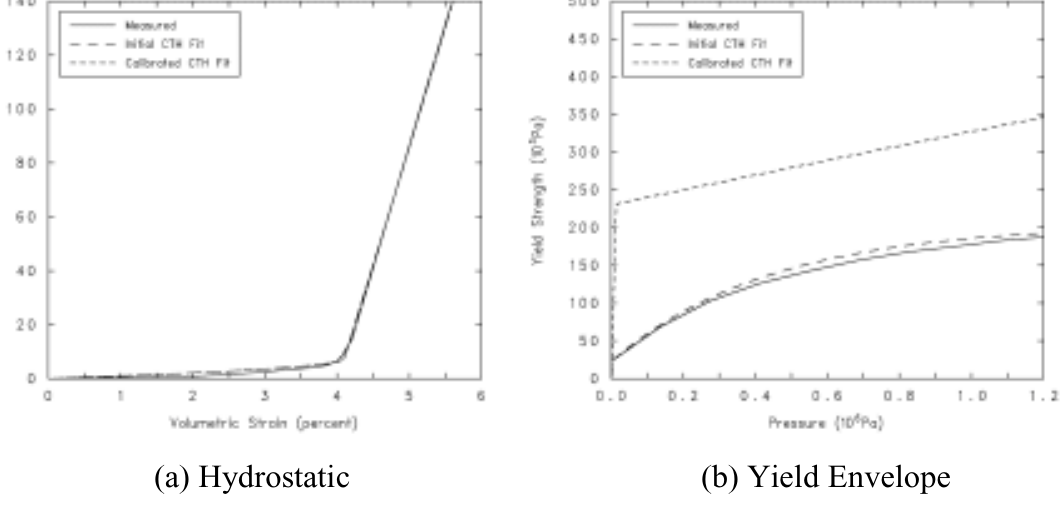
Fig. 4. Material response for clay.